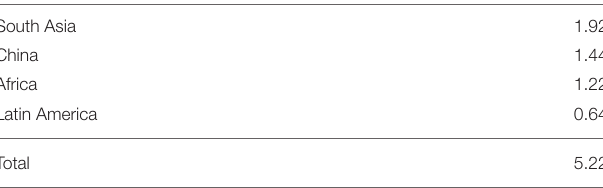
TABLE 2 | Estimated non-white populations in billions in selected regions of the world (Global population of whites account for < 1 billion; estimated world population of 7.7